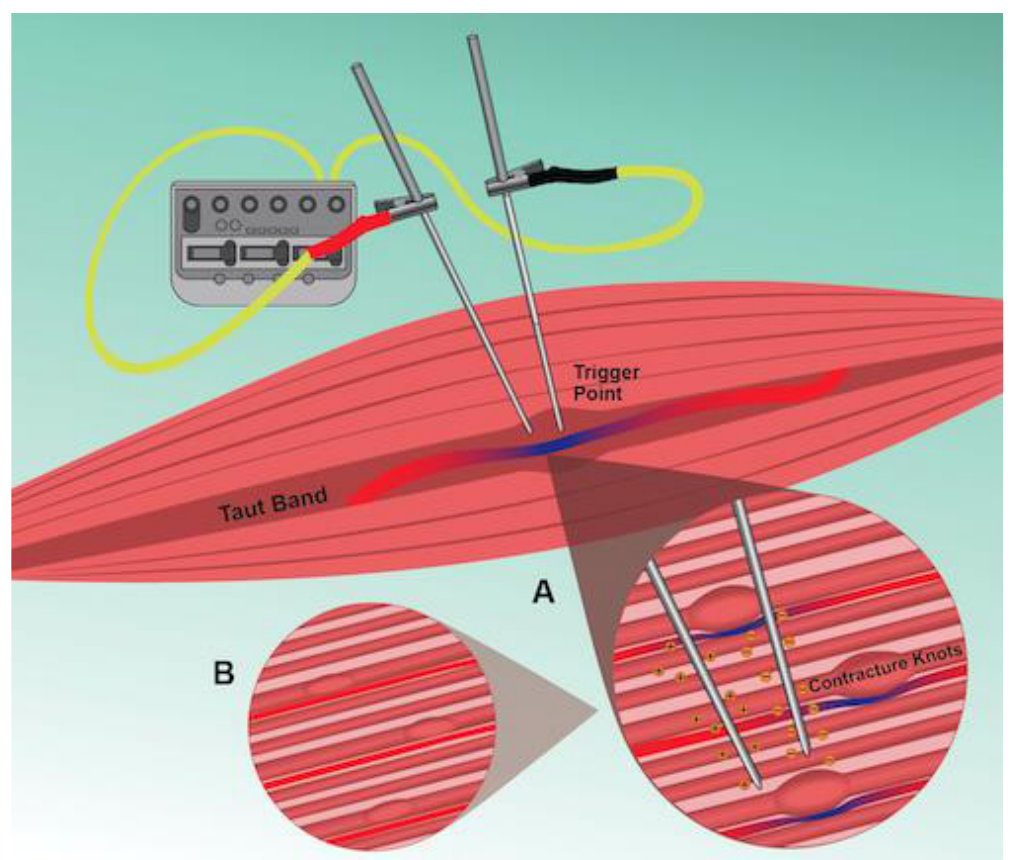
Figure 2. Schematic illustration of IMES to the TrP region. A: Delivery of a negative electrical charge into the TrP alters the potential difference across nearby neural membranes. Depending on the stimulation intensity, nerve depolarization, and production of compound action potentials will occur along motor and sensory nerve fibers. Local muscle contractions elicited by activation of motor fibers, or other reflex mechanisms, lead to vasodilation of blood vessels near or within the TrP. B: The increased microcirculation, and the prolonged depolarization of axon terminals combined with the production of LTRs elicited by IMES leads to depletion of acetylcholine (ACh) levels and reduction of EPN at the TrP.